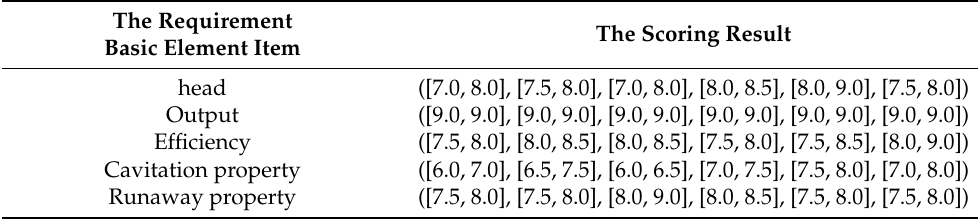
Table 4. The Scoring Results of Requirement Basic Element Items.